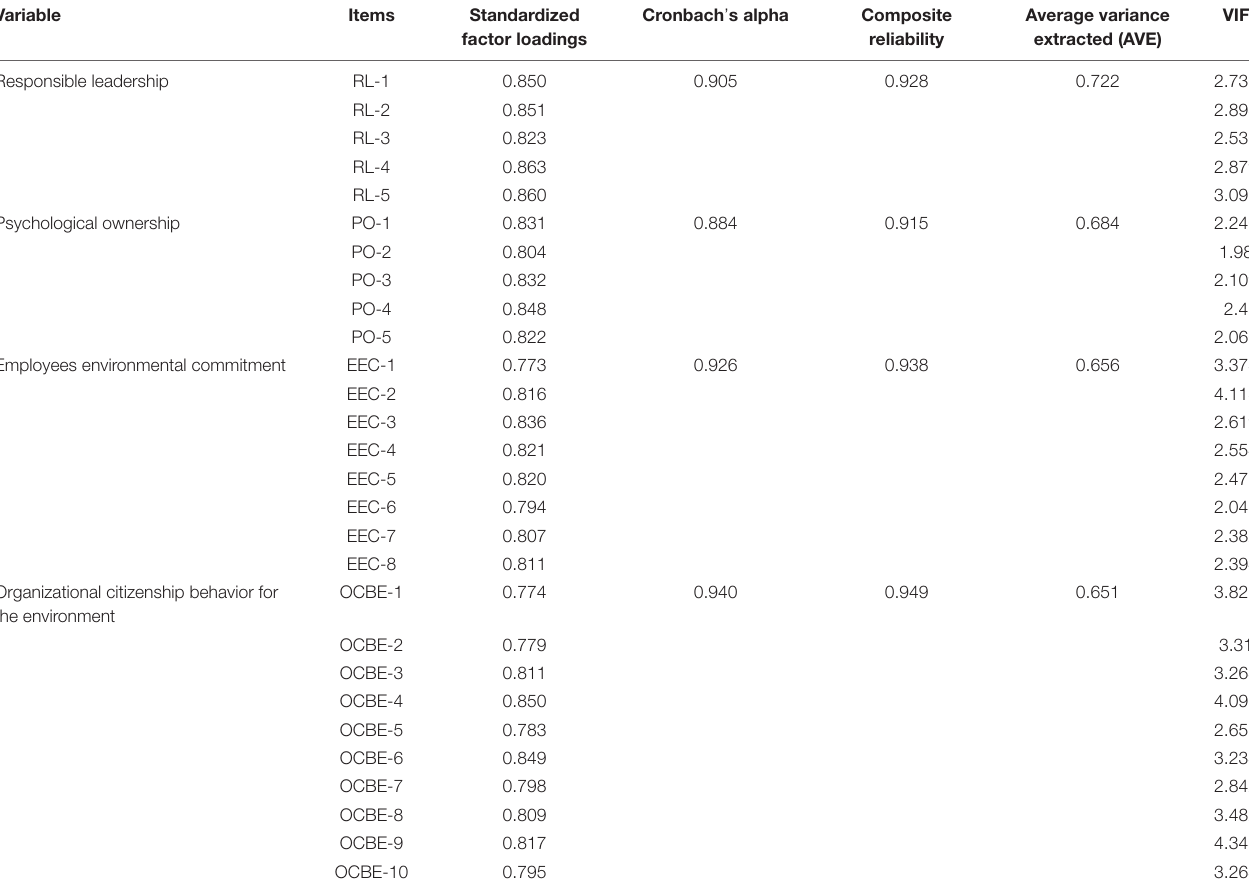
TABLE 2 | Convergent validity.